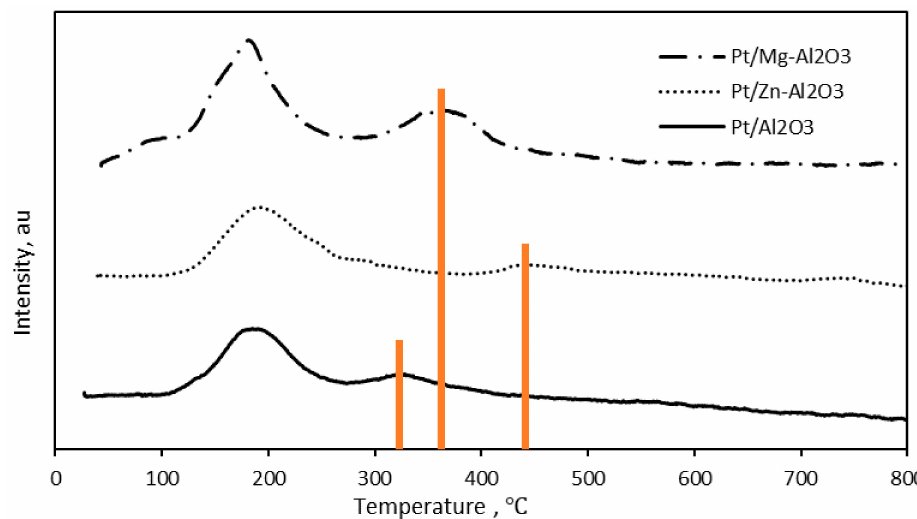
Figure 7. Hydrogen temperature-programmed reduction (H 2 -TPR) profiles of the calcined catalysts.